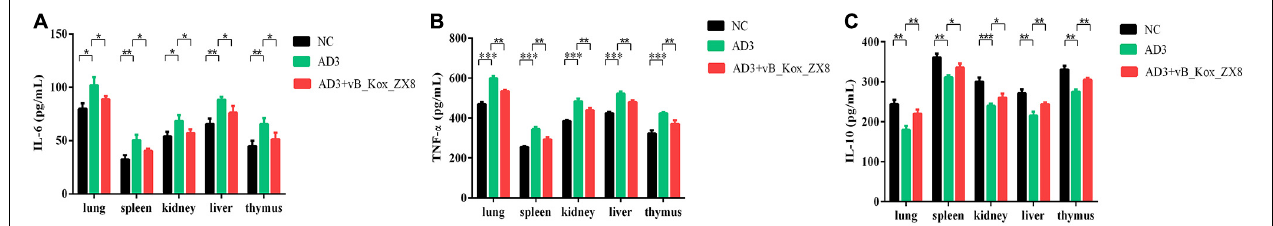
FIGURE 8 | Changes in immune factors in mice after phage vB_Kox_ZX8 rescue. (A) IL-6, (B) TNF- α , and (C) IL-10 levels in mice serum after injection with 5 × 10 6 CFU of K. oxytoca AD3 and 5 × 10 7 PFU of phage vB_Kox_ZX8, and the uninjected control (NC) are